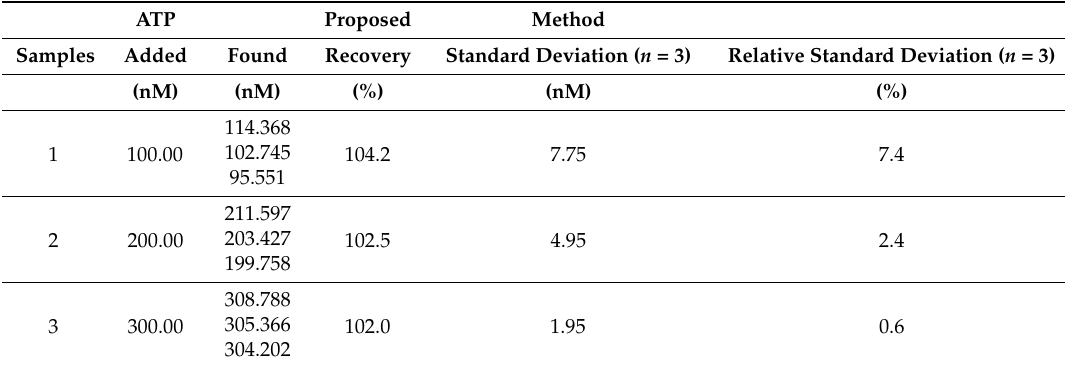
Table 4. Detection of ATP concentration in real urine